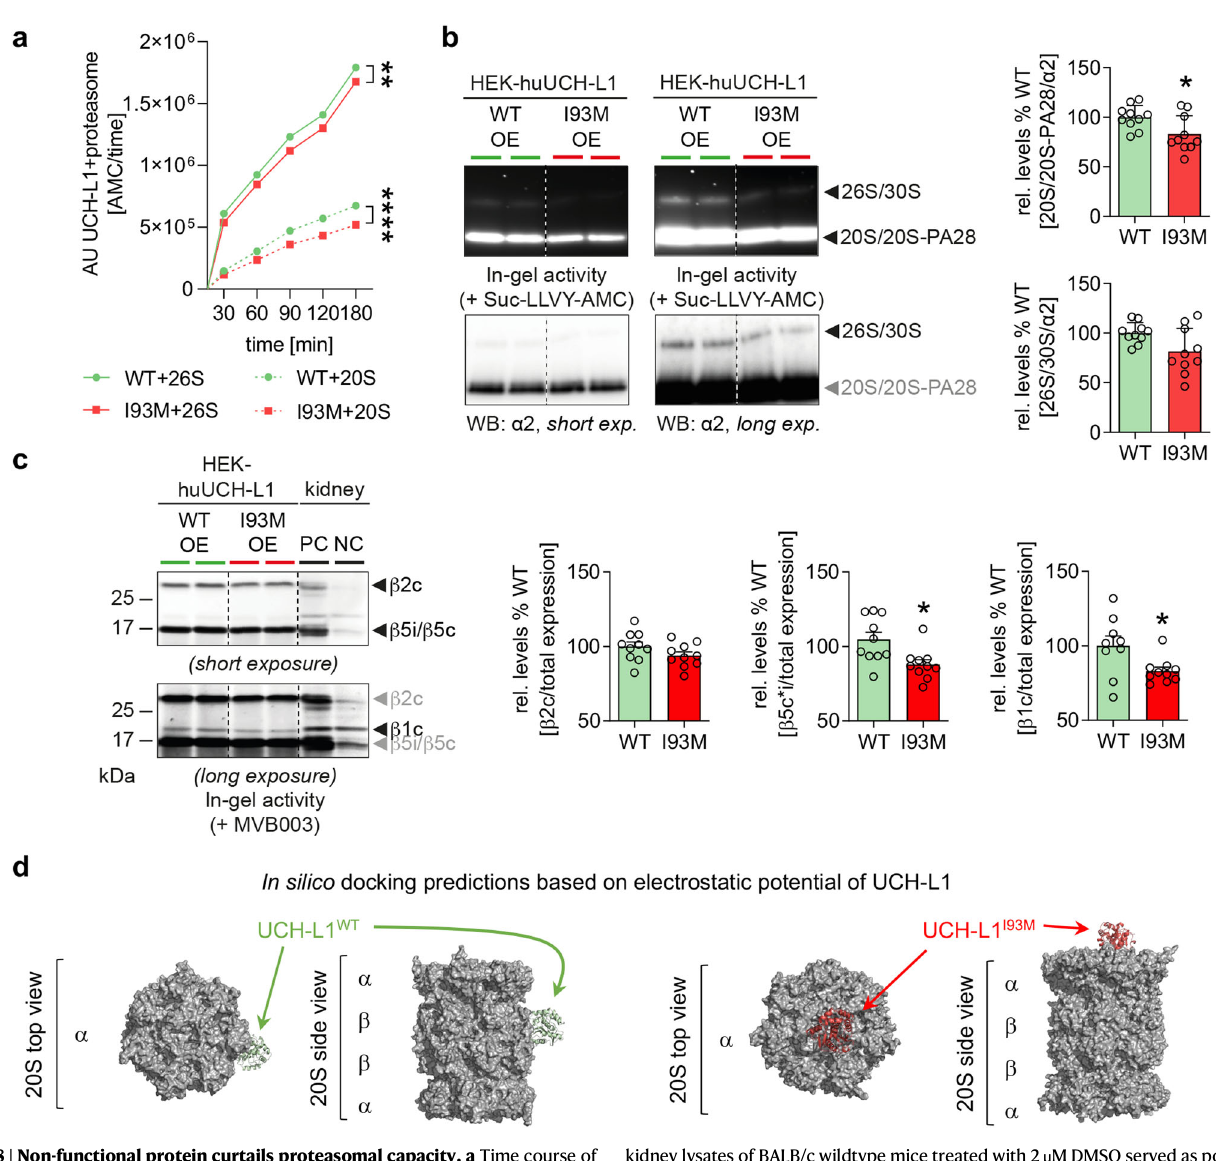
kidney lysates of BALB/cwildtype micetreated with 2 µ M DMSO served aspositive control (PC), treatment with 2 µ M epoxomicin as negative control (NC). Con- stitutive β 1c, β 2c, and β 5c subunit activities were normalized to total protein activity gel. Pooled values of3independent experiments, n =10 perconstruct( β 2c or β 5c*i) and n =9 (WT-UCH-L1) or n =10 (I93M-UCH-L1) for β 1c,